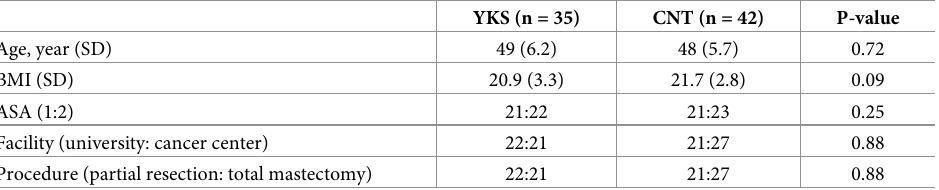
Table 1. Patient demographic